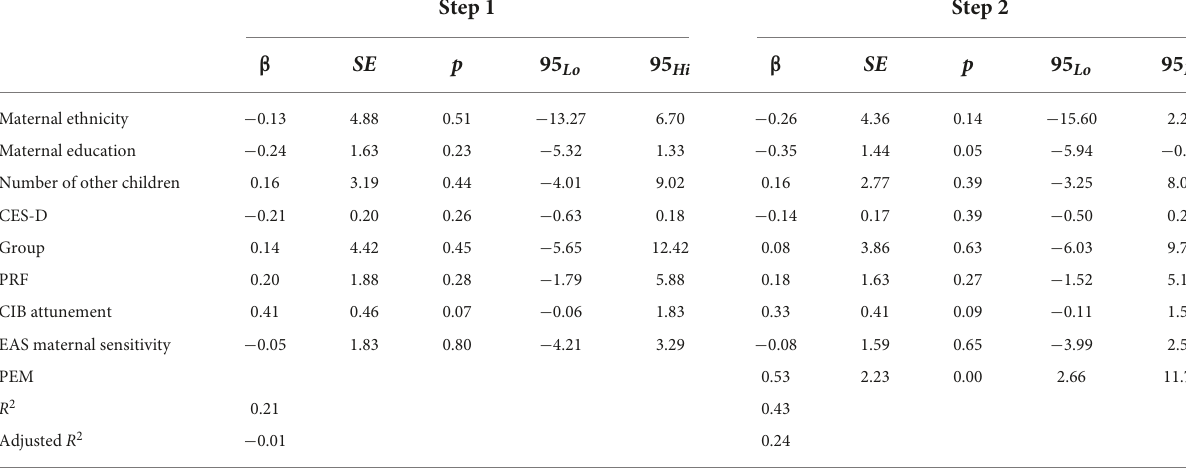
TABLE 4 Standardized regression coefficients for infants’ language development scores regressed on background